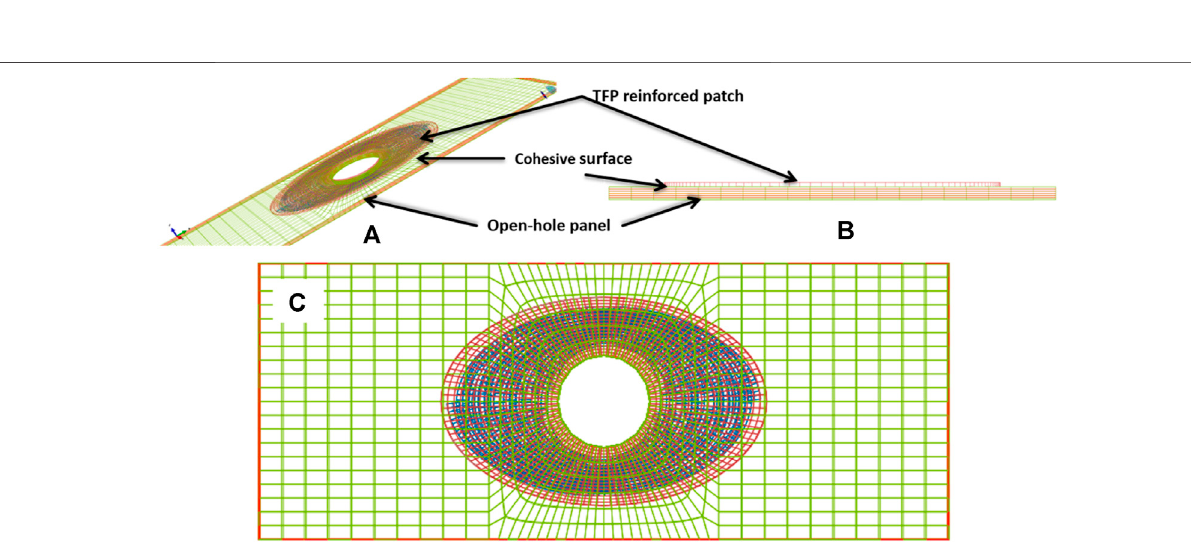
Frontiers in Materials |